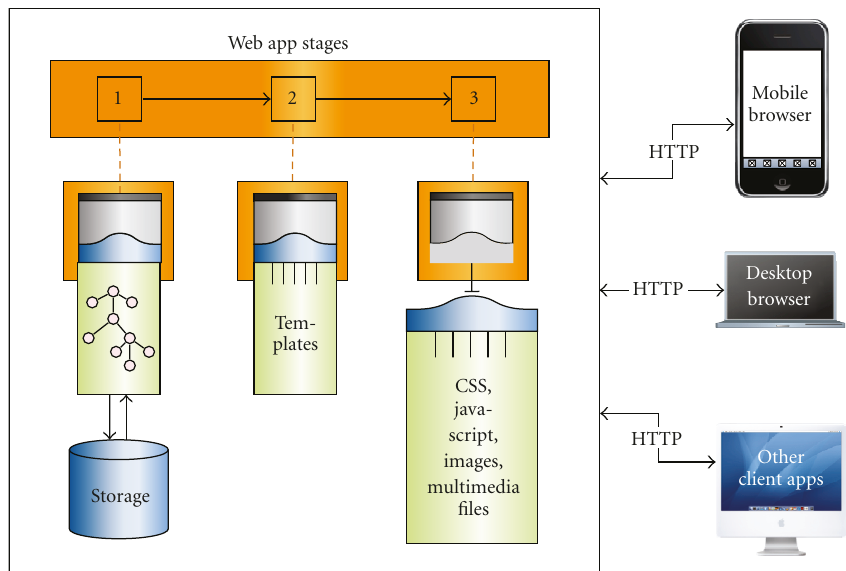
Figure 2: Ubiquitous Web service model